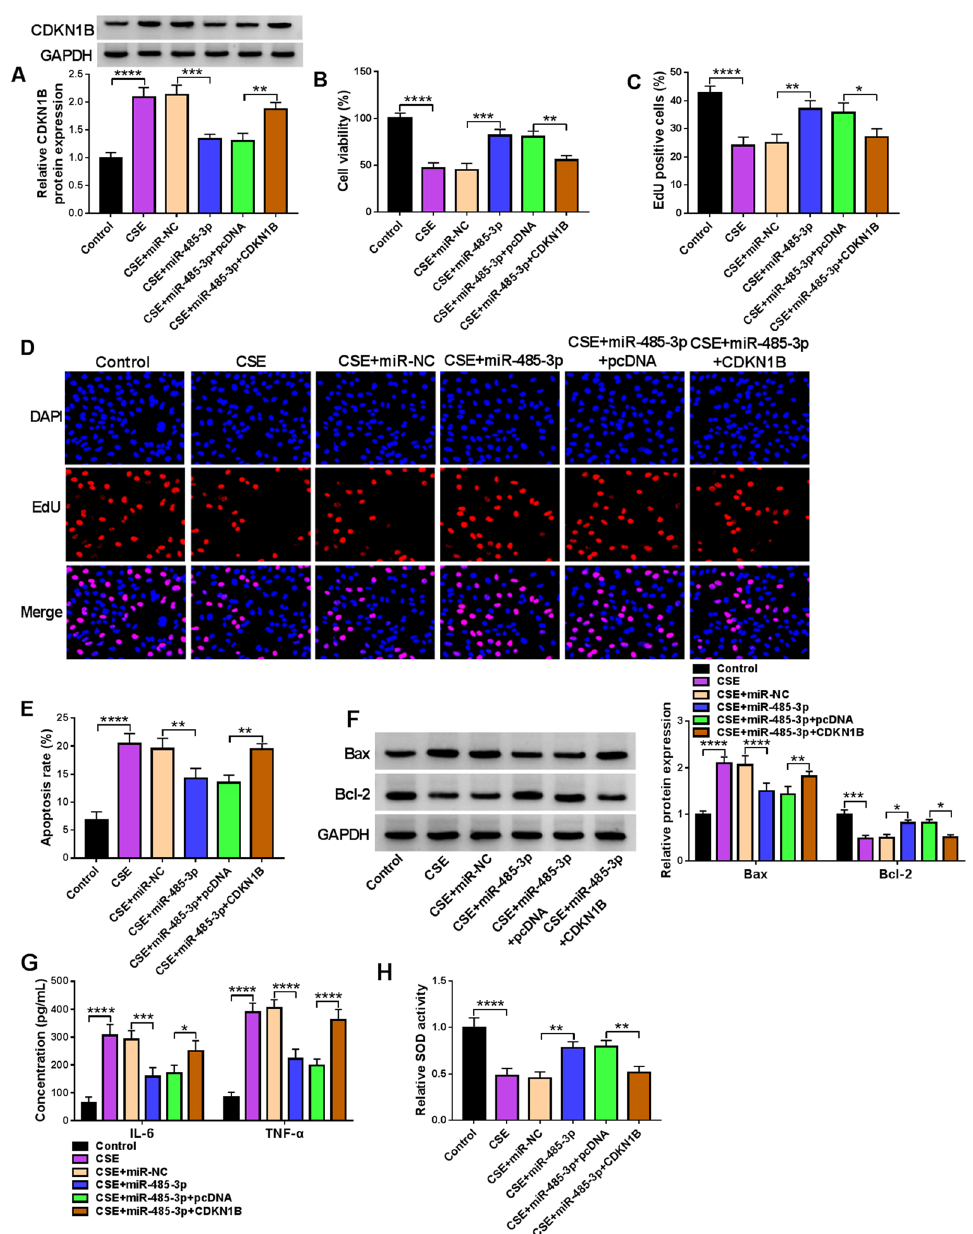
Fig. 7 miR-485-3p protects 16HBEC from CSE-induced injury via CDKN1B. A – H 16HBECs were co-transfected with miR-485-3p mimics and/or CDKN1B overexpression and then treated with 2% CSE for 24 h. A Transfection efficiency. B – D 16HBEC proliferation analysis. E 16HBEC apoptosis detection. F Levels of Bax and Bcl-2 in 16HBECs. G Levels of IL-6 and TNF-α in 16HBECs. H Measurement of SOD content in 16HBECs using a commercial kit. * P < 0.05, ** P < 0.01, *** P < 0.001, **** P <